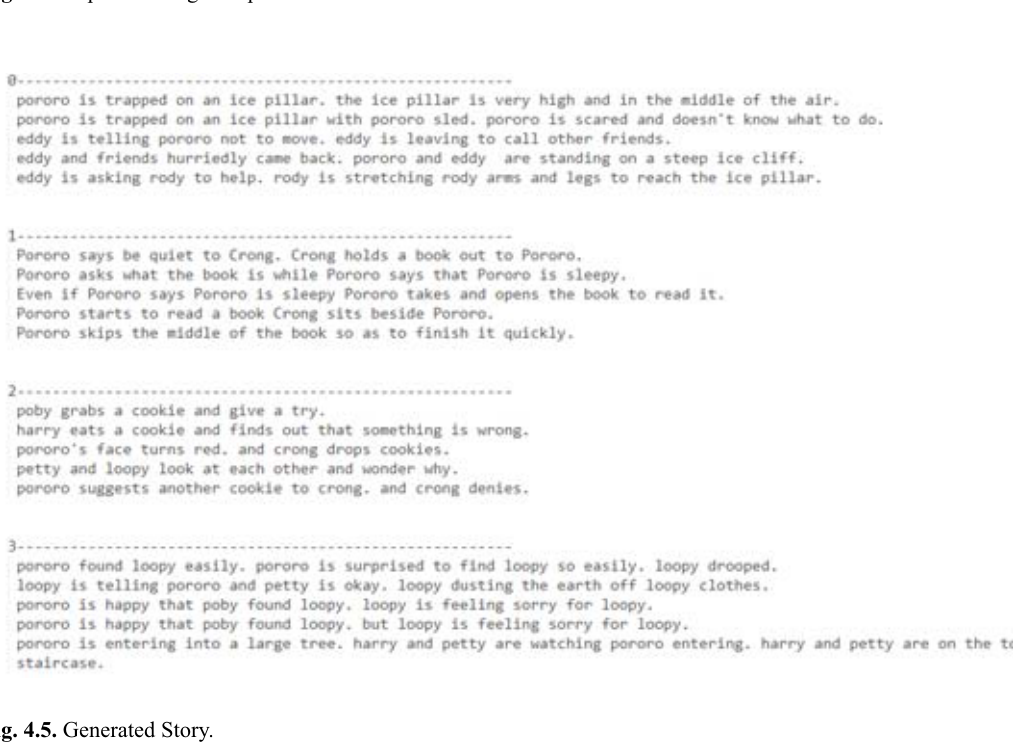
Fig. 4.4. Expected Image Output on Flintstones Dataset.